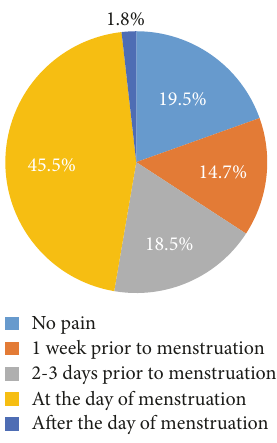
Figure 4: Onset of dysmenorrhea among female students of UOG, Gondar,